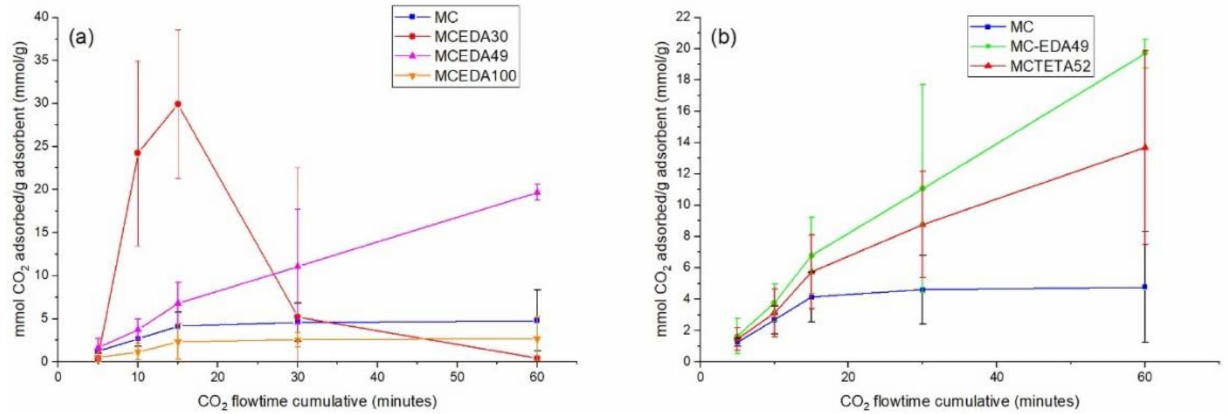
Figure 4. CO 2 adsorption capacity of MC and ( a ) MC-EDA; ( b ) MC-EDA50 and MC-TETA50, at pressure (P) of 5 atm at room temperature and with a CO 2 flow of 50